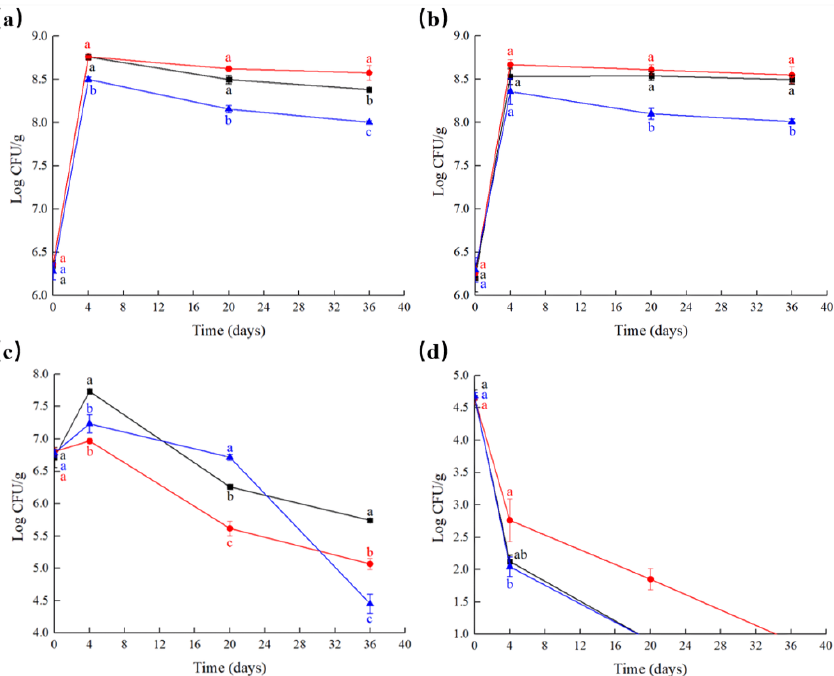
Figure 2. Evolution microflora of the fermented sausages. ( a ): Total viable bacterial counts, ( b ): lactic acid bacteria (LAB) counts, ( c ): Staphylococcus and Micrococcus counts, ( d ): Enterobacteriaceae counts. ( ■ ) N: fermented sausages with 3% NaCl (reference), ( ● ) L: fermented sausages with 2.25% NaCl (25% reduction), ( ▲ ) R: fermented sausages with partial replacement of 25% NaCl. The different lowercase letters indicate significant difference ( p < 0.05) between the samples by Tukey’s test.